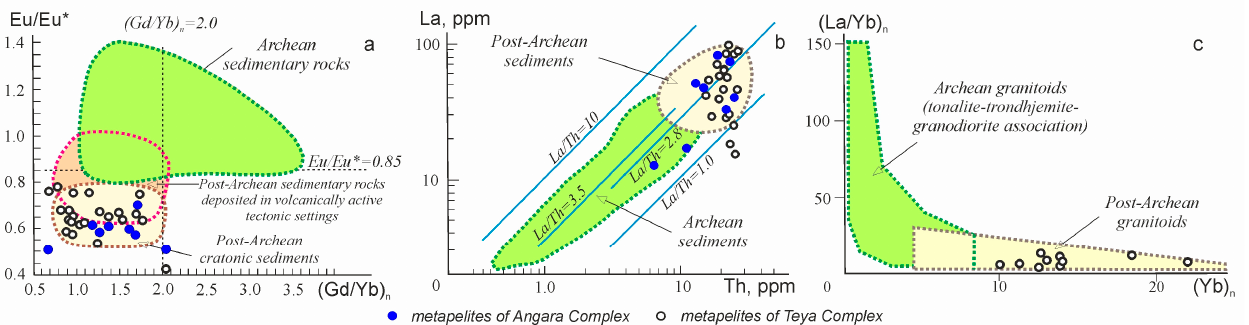
Figure 37. Data on metapelites of the Teya Complex and Angara area reported in the different plots and diagrams: ( a ) Eu/Eu* versus (Gd/Yb) n , ( b ) La versus Th plot, and ( c ) (La/Yb) n versus Yb n